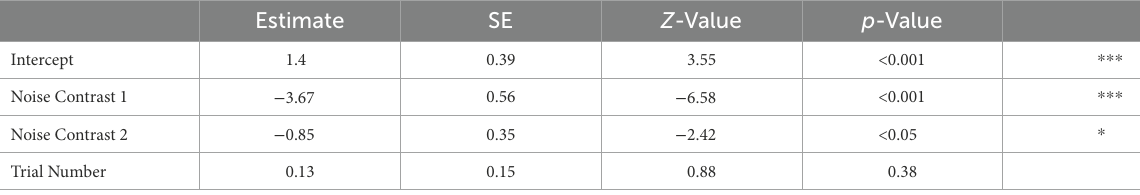
TABLE 5 Model outcomes for the subset of fricatives.